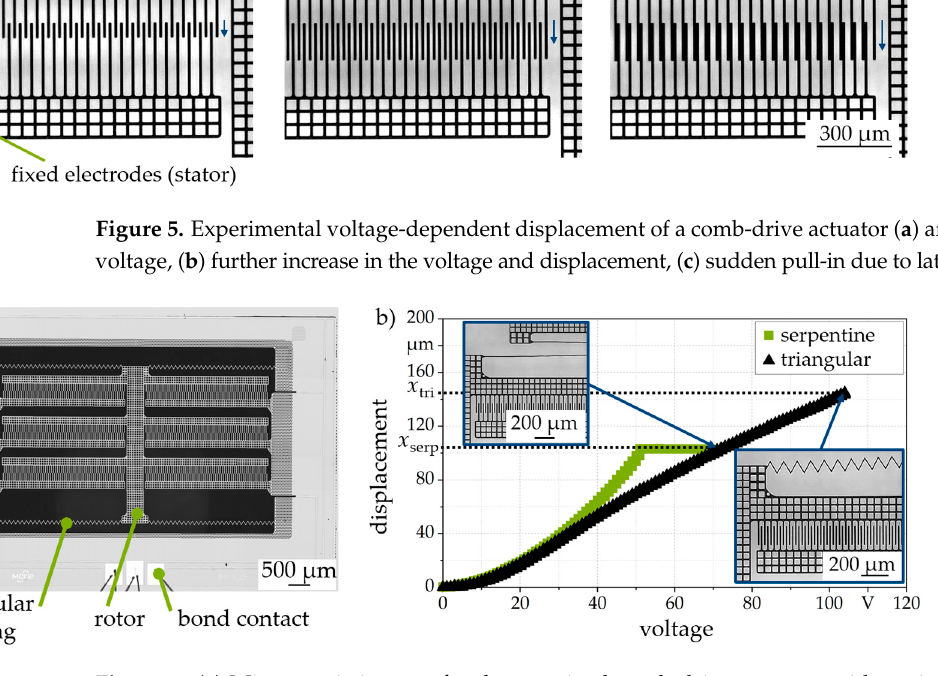
Figure 7. ( a ) Setup of an electrostatic parallel-plate actuator, ( b ) exemplary force–displacement char- acteristic curve, ( c ) exemplary electrode displacement depending on the applied voltage. The characteristic force–displacement curve of a parallel-plate actuator operating against a linear spring is outlined in Figure 7b. It does not allow control of the position across the whole range of the gap 𝑑 (cid:2868) . As the electrodes move closer together (with x = 𝑑 (cid:2868) − 𝑑 ), the electrostatic force increases with 𝐹~